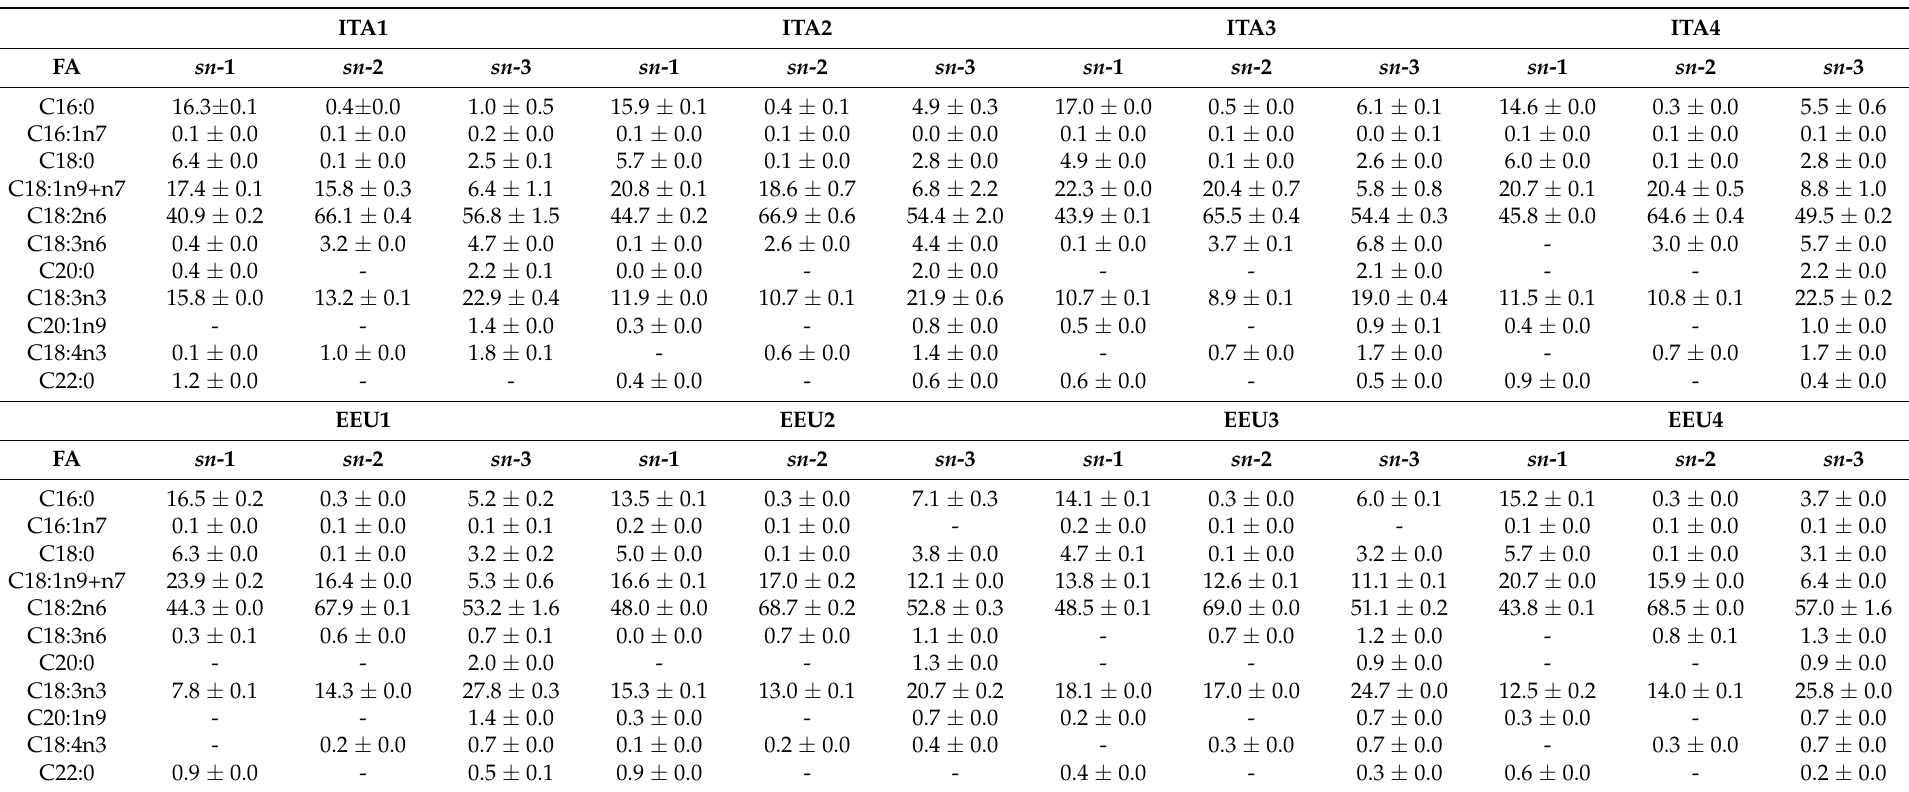
Table 3. Intrapositional % fatty acid composition (% mol, mean value ± SD, n = 4) of HSO